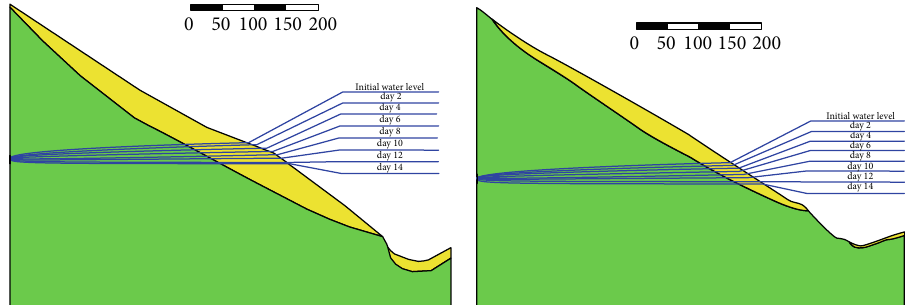
Figure 11: The dynamic seepage fi eld of two pro fi les of the glacio fl uvial deposit in rapid drawdown